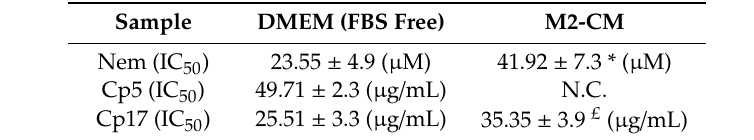
Table 3. IC 50 values of Nem and Cp samples. Treatment was performed in DMEM or in combination with M2-CM.